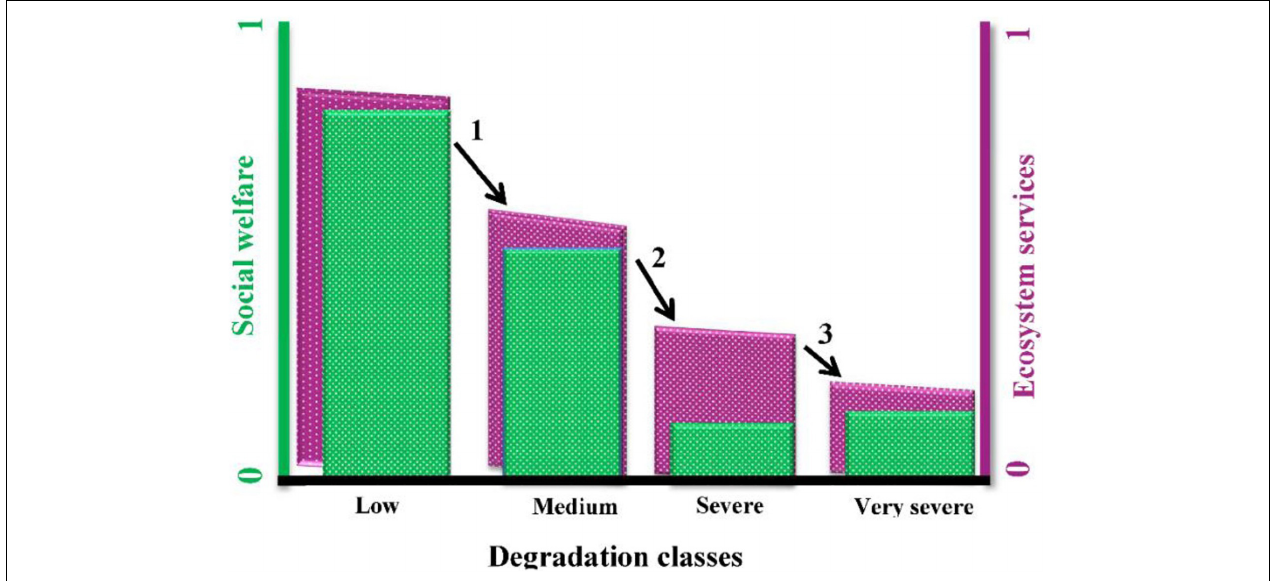
FIGURE 6 | Relative loss of ecosystem services and social well-being under the degradation classes.